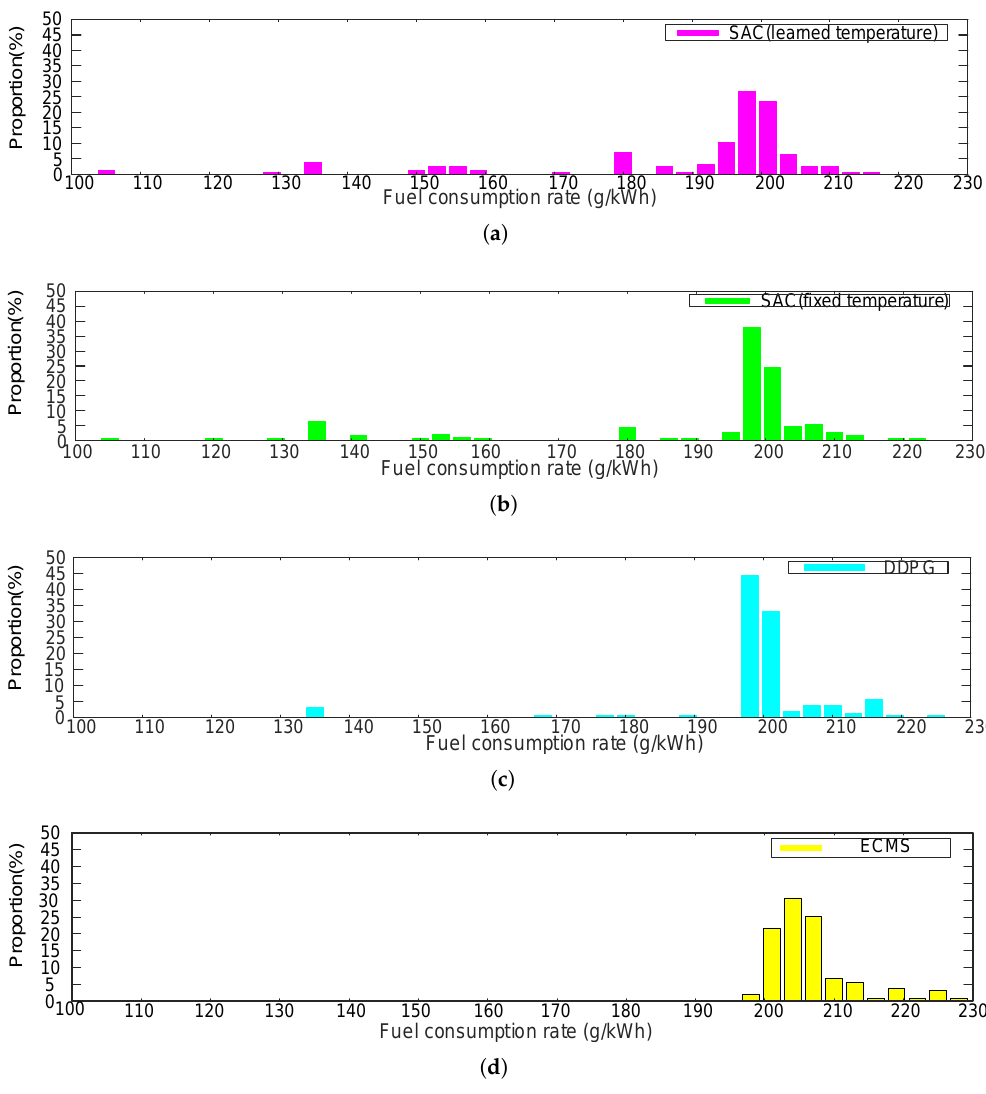
Figure 15. The efficiency distribution of ICE working points of the four strategies. ( a ) SAC-AET strategy. ( b ) SAC (fixed equilibrium parameter) strategy. ( c ) DDPG strategy. ( d ) ECMS